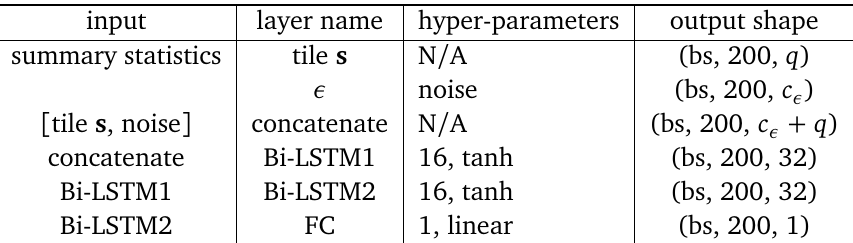
Table 2: Decoder architecture of ENCA. Bidirectional (Bi)-LSTM layer details corre- spond to number of LSTM filters ( × 2 due to Bi) and activation, respectively. Fully connected (FC) layer details correspond to number of hidden units, and activation, respectively. Output shapes are listed for an initial observation length of 200 steps constructed using noise vector ε ∈ (cid:82) 200 × c ε having c ε channels. Minibatch size is denoted as bs. Note that c ε is 1 and 2, for the two test models, respectively. Tile layer corresponds to broadcasting operation along a new axis. For more details, please refer to our repository.